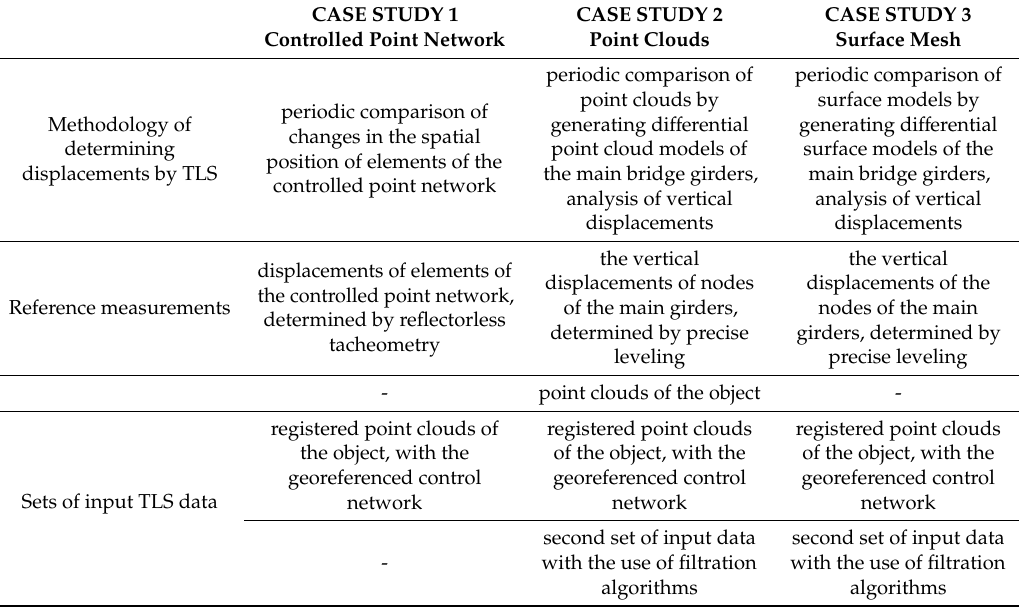
Table 5. Procedures of post-processing of TLS data, defined in three case